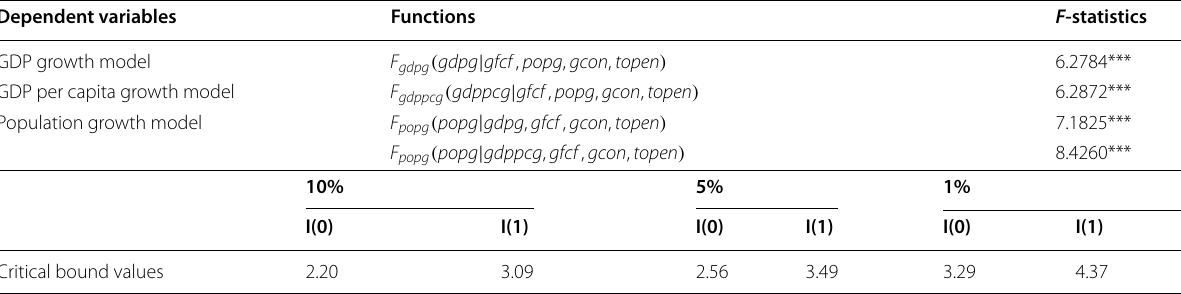
Table 4 ARDL bounds test result for cointegration